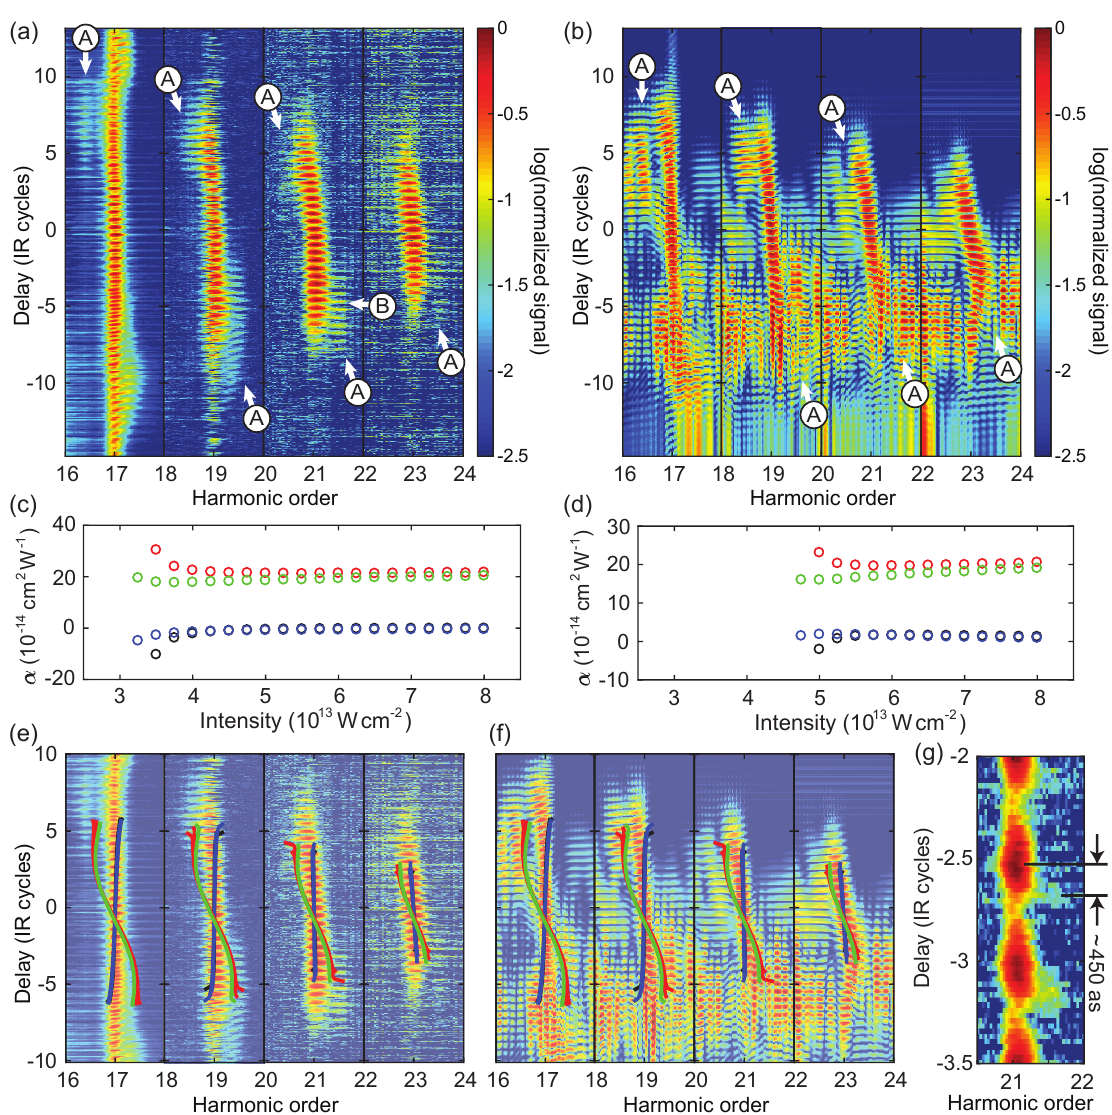
Figure 4. Delay-dependent frequency shifts around harmonics H17 to H23. ( a ) Experimental data. We normalize the signal for each harmonic order separately. The arrows indicate characteristic features in the spectrum: A, strongly frequency-shifted spectral components, with positive (negative) shifts for negative (positive) XUV–IR delays; B, sub-cycle temporal delay of the oscillations of the shifted spectral components with respect to the odd harmonic signal. ( b ) TDSE calculation results. ( c ) The Coulomb-corrected three-step model (CCTSM) α parameter for H19 as a function of intensity. The black (blue) circles indicate downhill (uphill) short trajectories and the red (green) circles indicate downhill (uphill) long trajectories. ( d ) The same as frame (c), but for H21. ( e ) CCTSM results overlaid with the experimental color plot. The black (blue) curves indicate downhill (uphill) short trajectories and the red (green) curves indicate downhill (uphill) long trajectories. ( f ) CCTSM results overlaid with the TDSE color plot. ( g ) Zoom into H21 from frame (a). The XUV–IR oscillations of the short trajectories are lagging behind those of the much fainter blue-shifted long trajectories by about